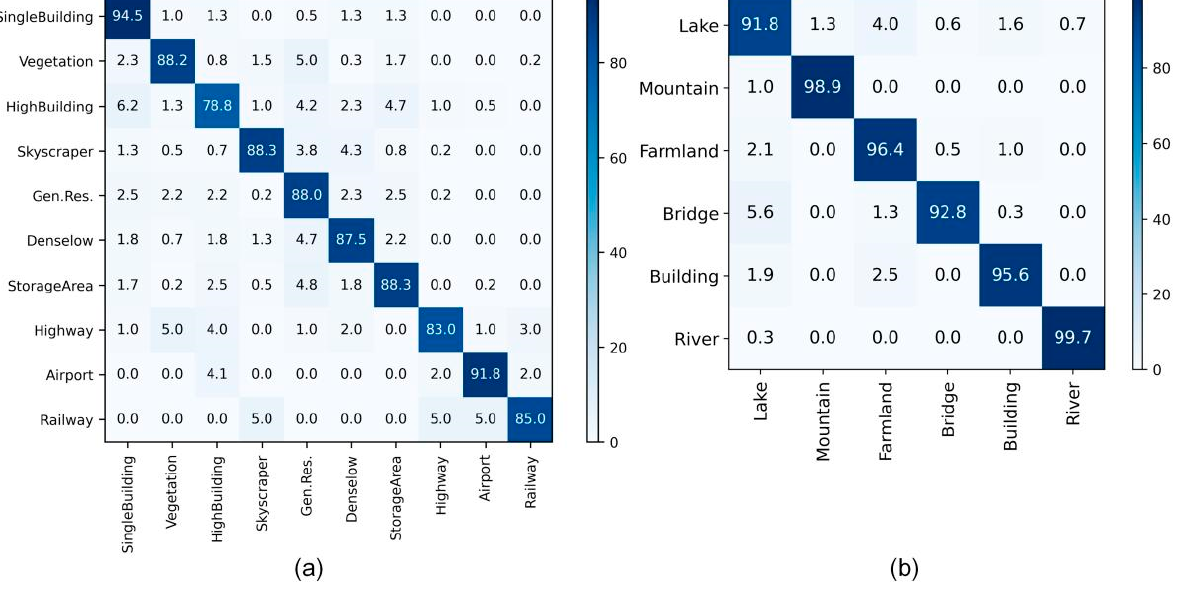
Figure 9. Confusion matrix of fine-tuned results: ( a ) on OpenSARUrban with 20% training proportion; ( b ) on WHU-SAR6 with 20% training proportion.